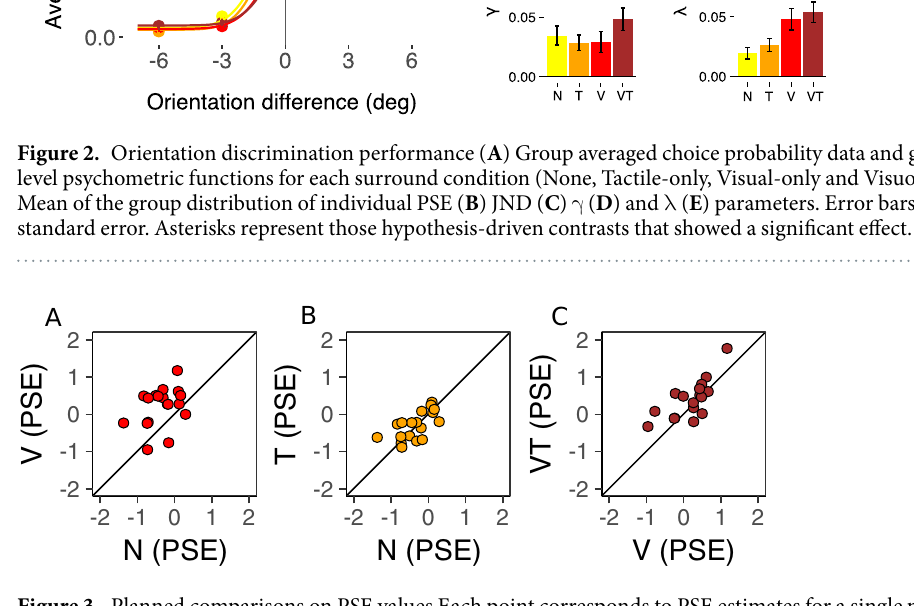
Figure 3. Planned comparisons on PSE values Each point corresponds to PSE estimates for a single participant. ( A ) Comparison between the baseline condition (N) containing no surround orientation information and the visual-only condition (V). ( B ) Comparison between the baseline condition and the tactile-only condition (T). ( C) Comparison between the visual-only condition and the visuo-tactile condition (VT). Points above the unity line indicate subjects exhibiting larger repulsive tilt illusion effects in the condition plotted on the ordinate compared to the